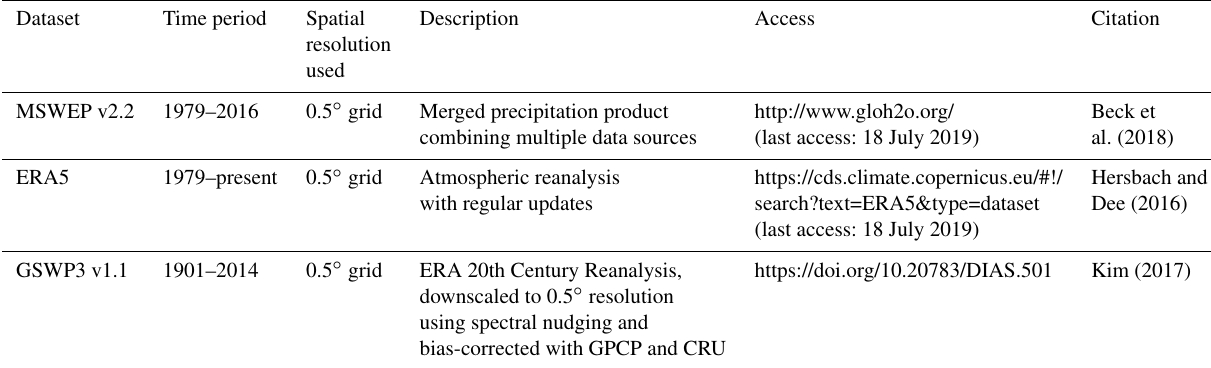
Table 2. Meteorological forcing